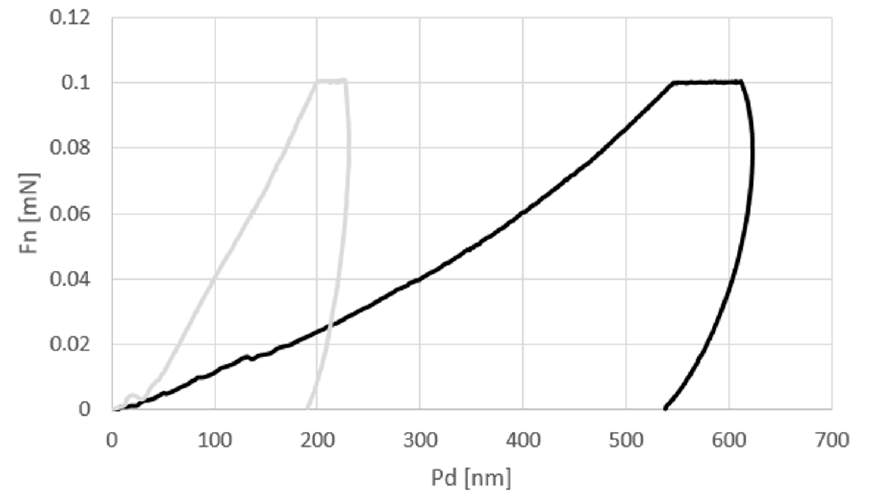
Figure 1. Average Fn vs. Pd from the indentation hardness tests.